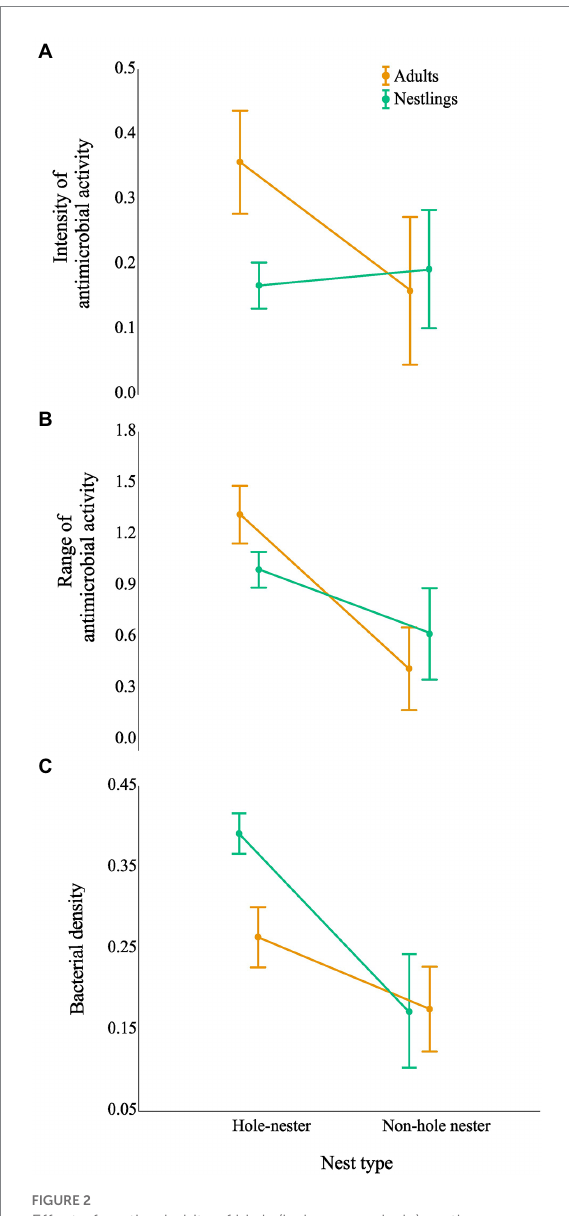
FIGURE 2 Effect of nesting habits of birds (hole vs non-hole) on the antimicrobial capacity and bacterial density of the community living on their uropygial gland skin. Graphs show the estimated antimicrobial capacity: (A) intensity of antimicrobial activity (average values of the width of antagonistic halos (mm) when tested against each of the nine indicator bacteria) and (B) antimicrobial range (Shannon index of the antimicrobial activity), as well as (C) density of bacteria isolated from the birds’ gland skin after controlling for species identity nested within nest type. Results for adults and nestlings are shown in different colours. Values are least square means ±95%